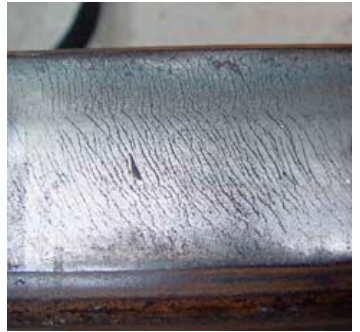
Figure 12. Rail surface fault.